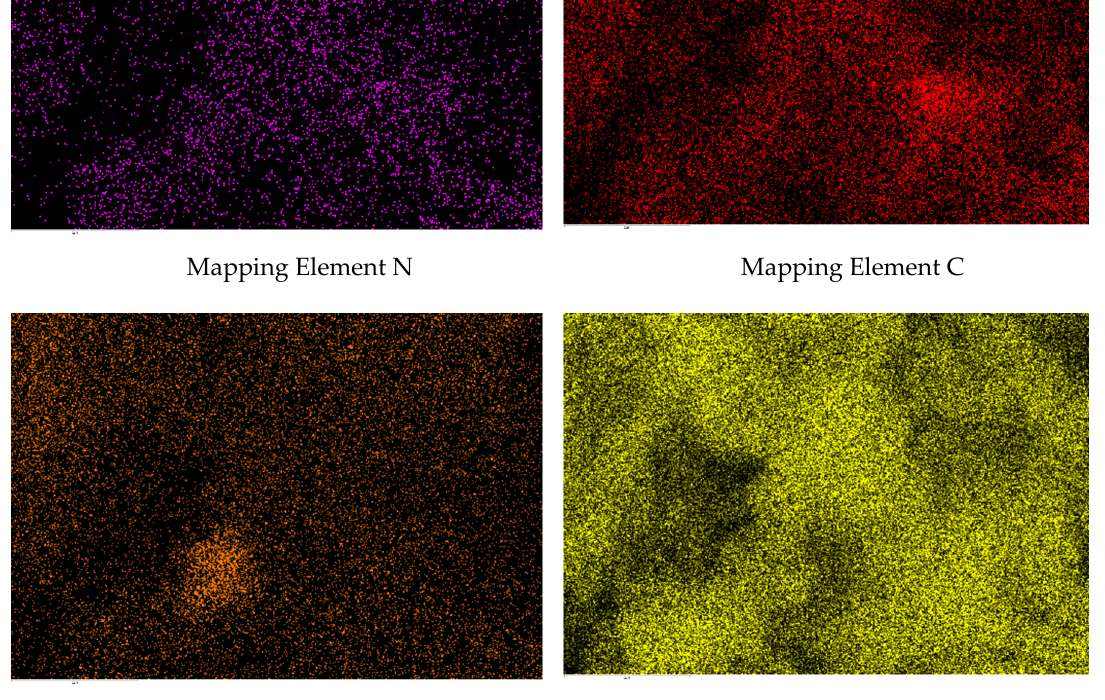
Figure 8. Scanning electron microscopy (SEM) of LiFePO 4 –PANI coupled with energy dispersive spectroscopy (EDS).